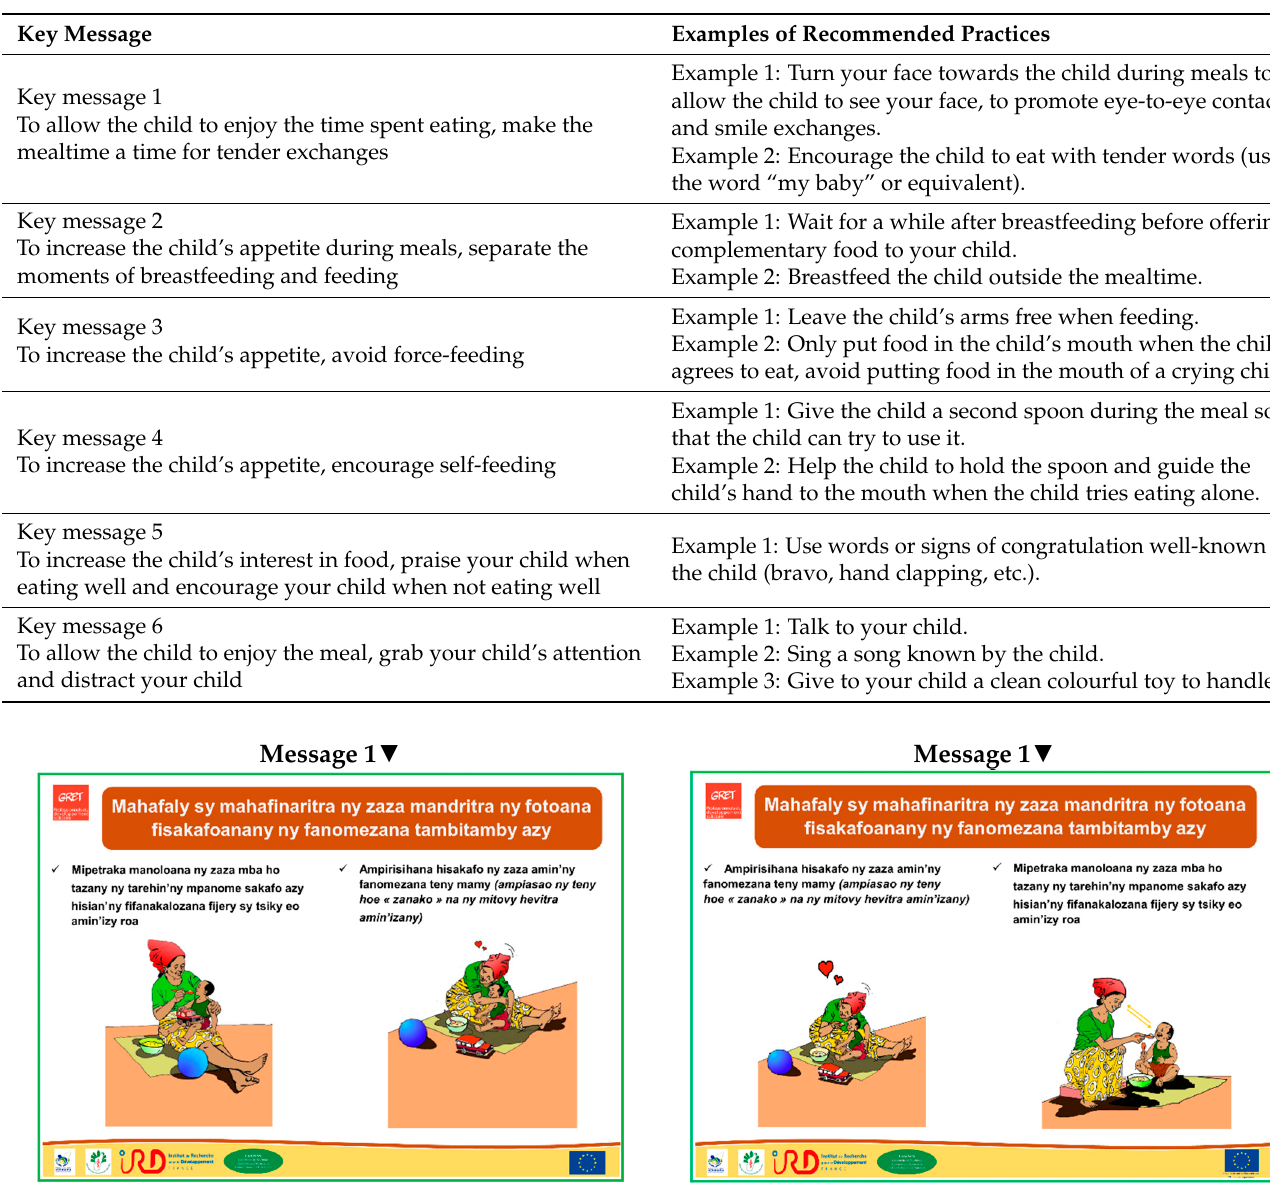
Table 8. Six key messages proposed for the promotion of responsive feeding and the corresponding examples of recommended practices.